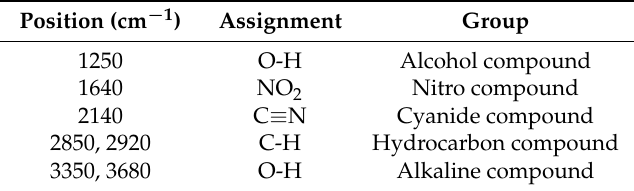
Figure 9. Infrared spectra of gold plate under conventional and Bi intensification cyanidation. Table 3. FT-IR spectra of the gold plates under different conditions.